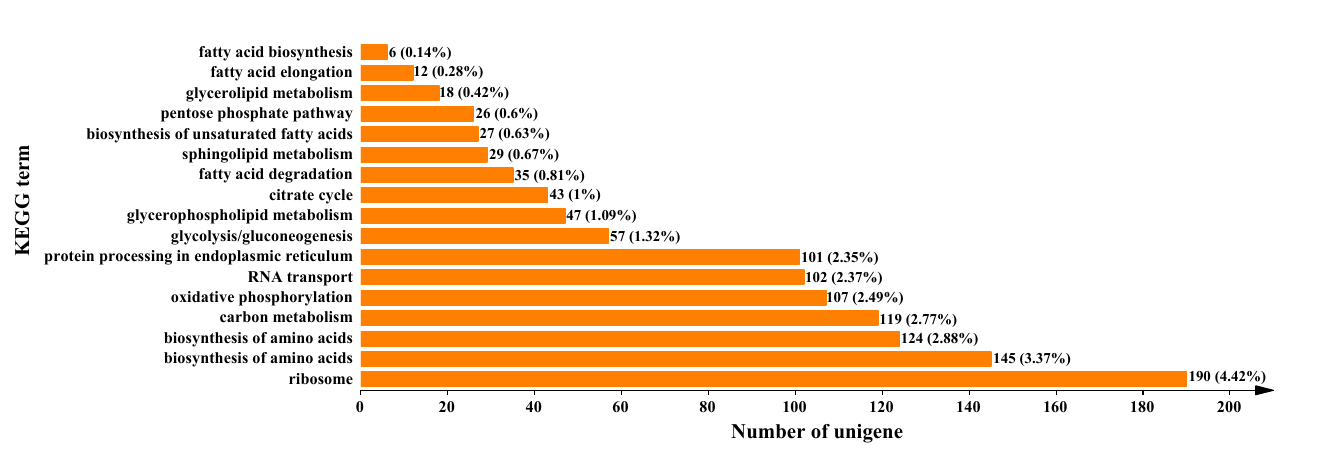
Figure 3. Functional annotations of the unigenes of Mortierella alpina based on the Kyoto Encyclopedia of Genes and Genomes (KEGG) database.